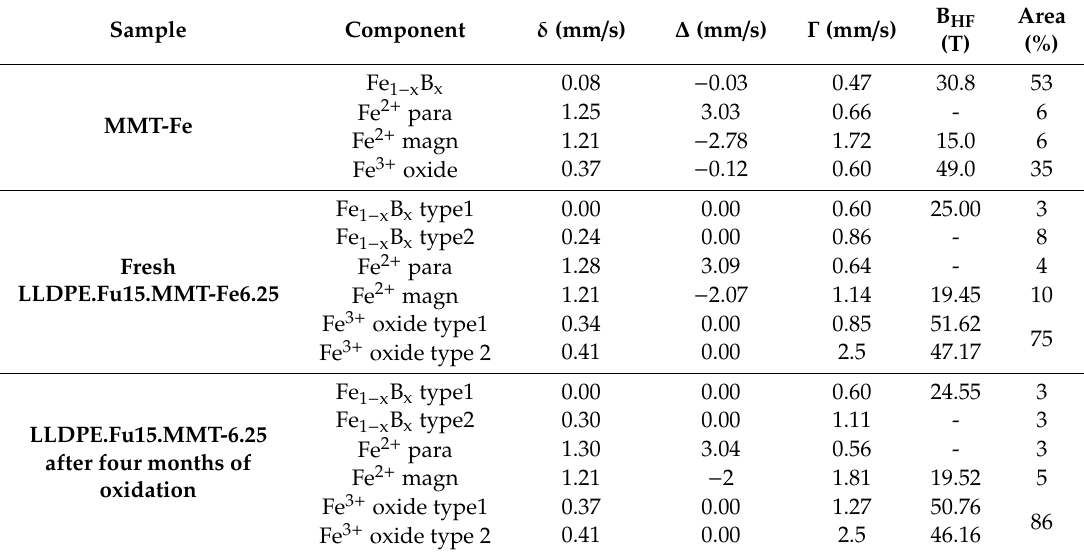
Table 3. 57 Fe Mössbauer parameters at 5 K for samples MMT-Fe, fresh LLDPE.Fu15.MMT-Fe6.25, and aged